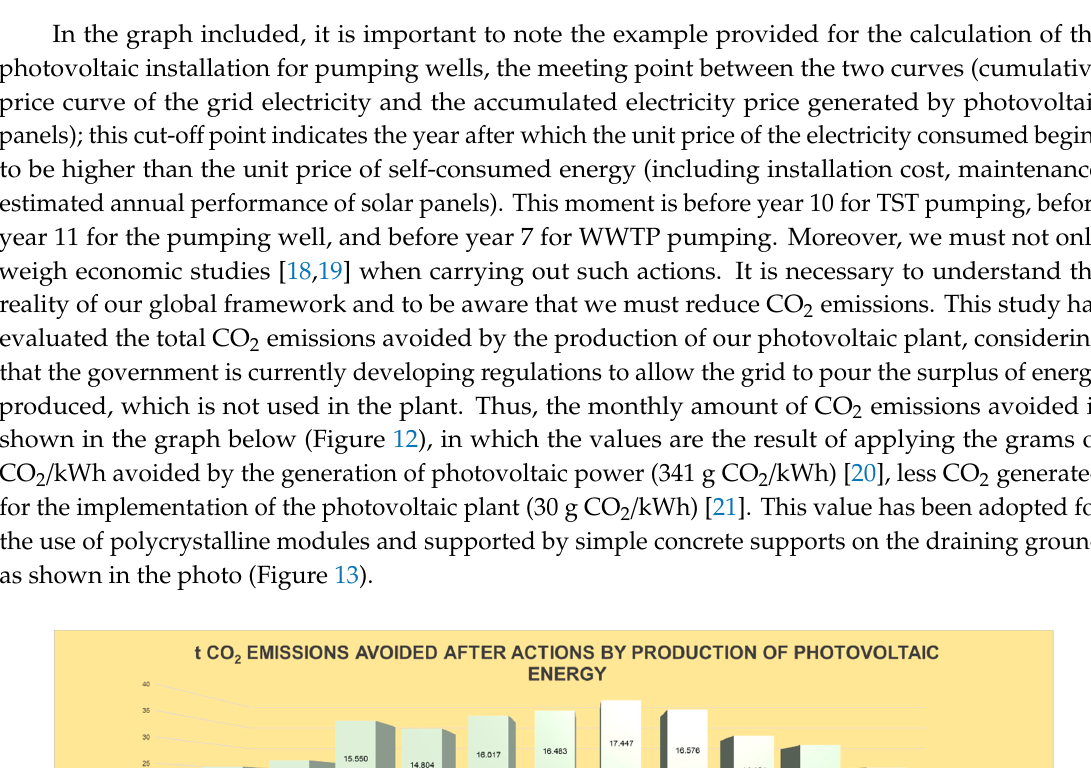
Figure 11. New WUA operating scheme.